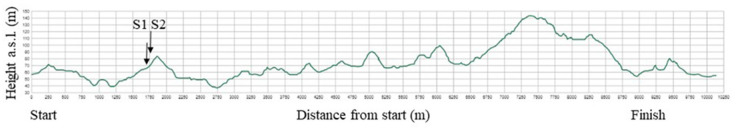
Height above sea level [a.s.l. (m)] of the 10 km ski skating cross-country race course vs. distance from start (m). Profile (m) of the 10 km ski skating cross-country race course vs. height above sea level [a.s.l. (m)]. Females covered three laps and males five laps. S1 (5.0° incline) and S2 (8.1°) indicate sections where skiers were filmed. See text for further details.